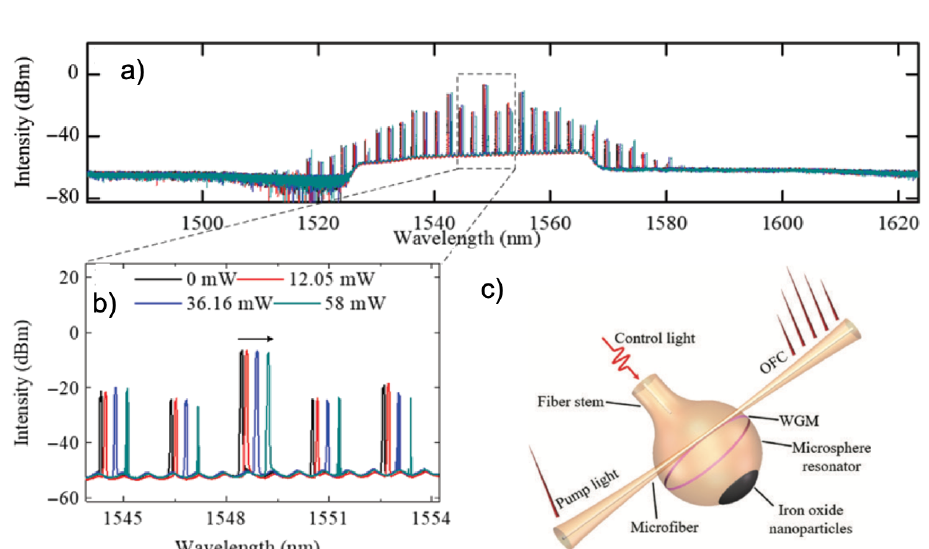
Figure 4. ( a ) Generated Kerr combs in a hybrid microsphere for different control light powers, ( b ) zoom-in of the spectra of panel ( a , c ) Sketch of experimental set-up showing an iron oxide nanoparticle coated silica microsphere of 248 µ m diameter for photothermal tuning of generated optical frequency combs (OFC). The pink ring is the excited whispering gallery mode and the black polar cap represents the coated area with iron oxide nanoparticles. Reproduced with modifications from Ref.